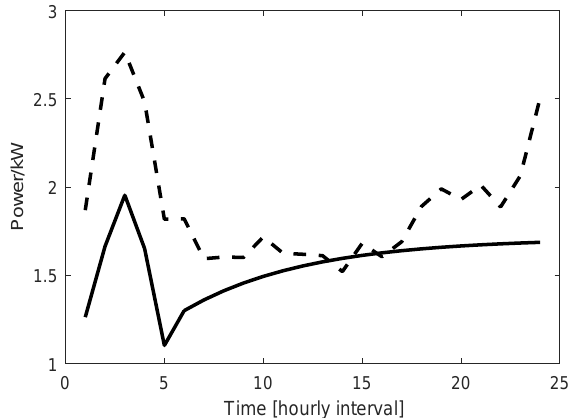
Figure 8. Power usage of one heat pump of Rtl 1 at bus 1. Solid line represents the power before TE, dashed line shows the power after